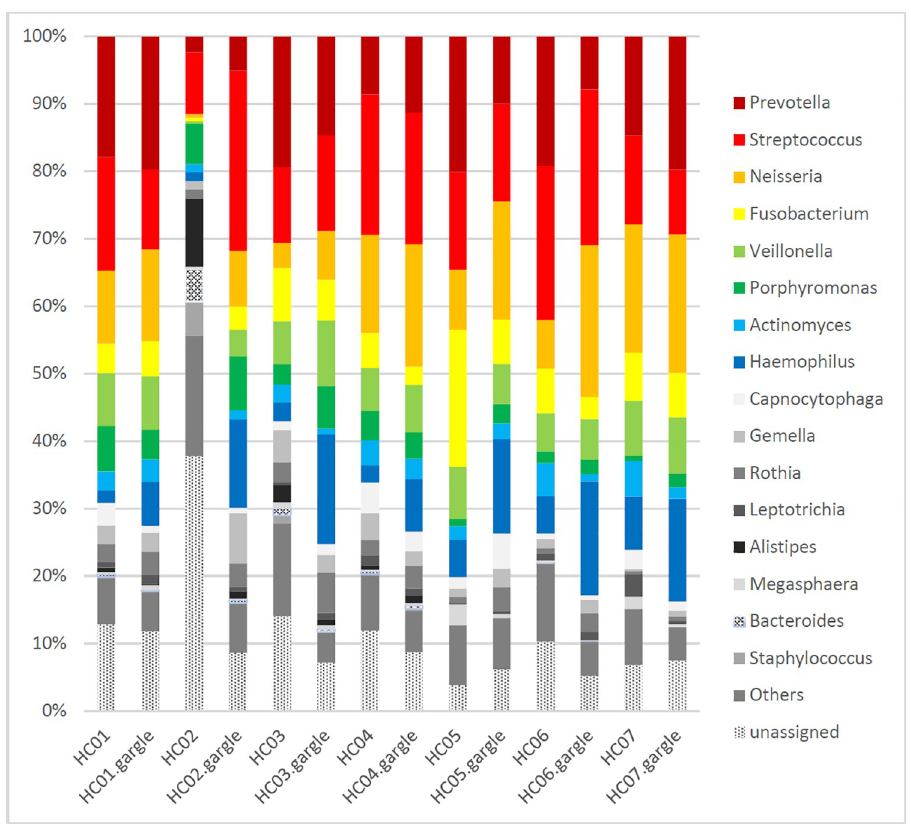
Fig 1. Relative abundance of microbial community constituents in endotracheal tube washings and oral gargles from seven healthy respiratory control group. Taxa that did not show more than 3% abundance in at least one specimen were designated as “others”.